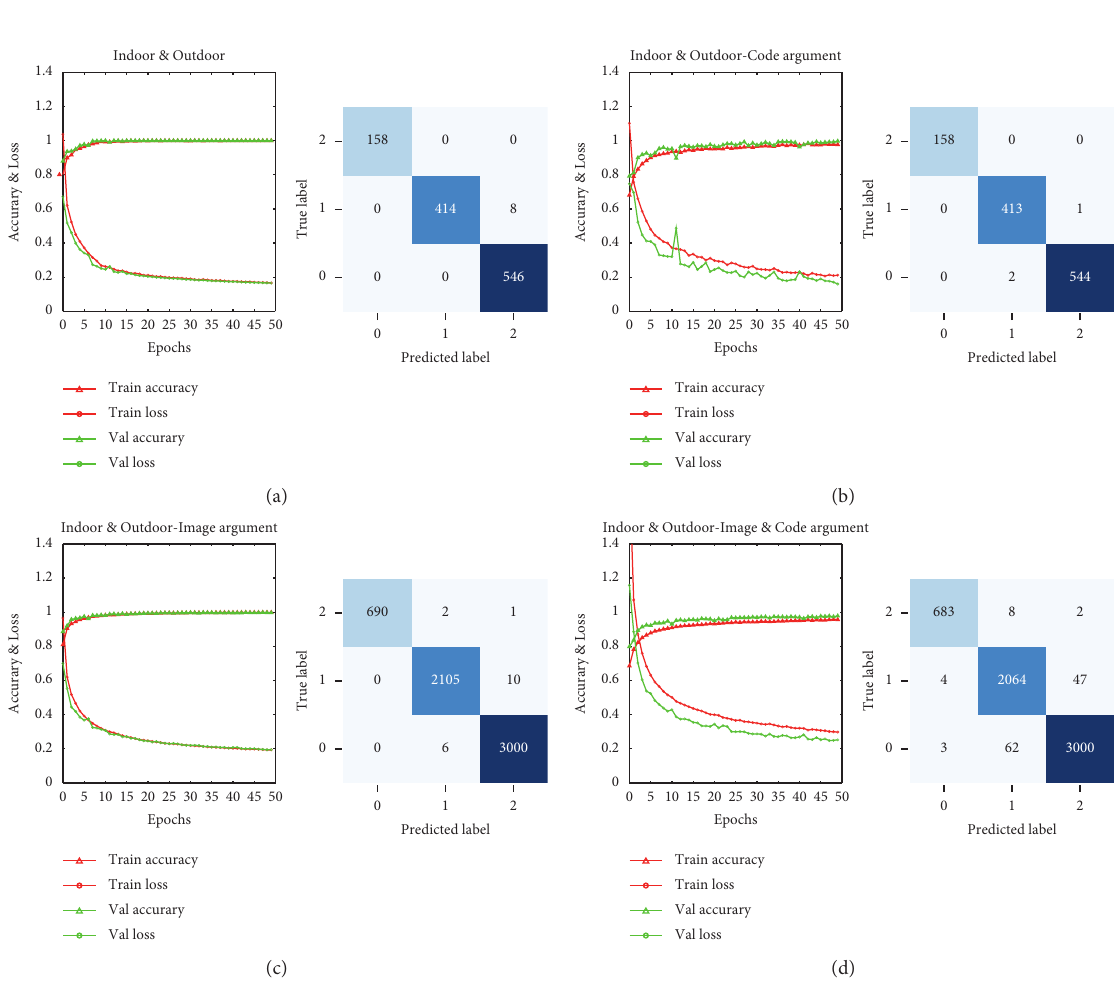
Figure 9: Combined outdoor and indoor results for (a) out-indoor without code, (b) out-indoor with code, (c) out-indoor image augmentation without code, and (d) out-indoor image augmentation with code.